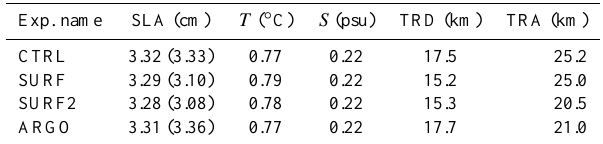
Table 1. Design of numerical experiments, the assimilated obser- vations are marked with X. SLA (sea level anomalies), TEM (tem- perature profiles), SAL (salinity profiles), TRD (surface drifter po- sitions), and TRA (Argo float positions).